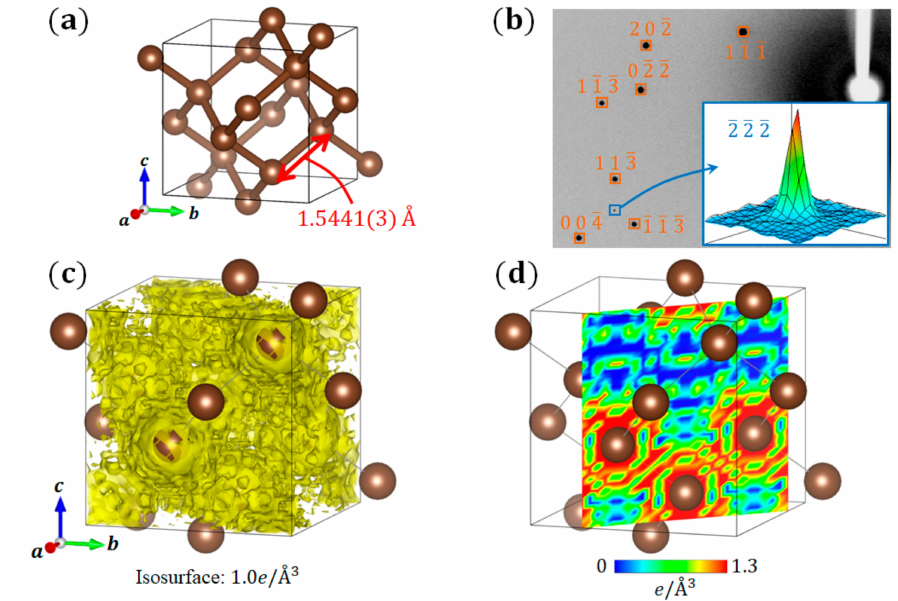
Figure 2. ( a ) Crystal structure of diamond; ( b ) Synchrotron X-ray di ff raction (XRD) data of a diamond crystal at 30 K. ( c , d ) Total electron density (ED) distribution of diamond calculated by the general inverse Fourier transform of di ff raction intensity using Equation (5); ( c ) Surface plot; ( d ) Sectional view of the (4 4 0)